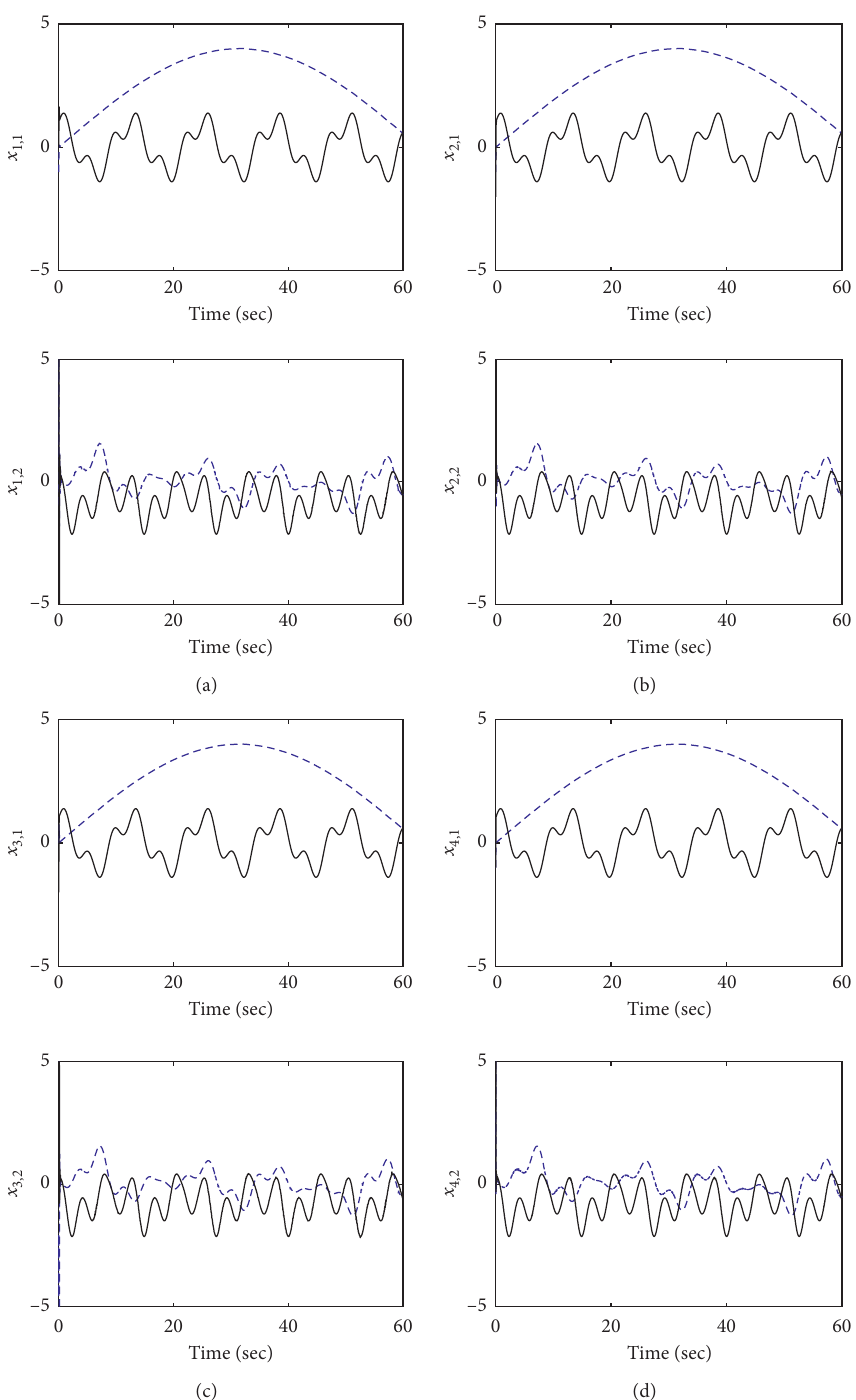
Figure 4: The states of the four followers. (a) x